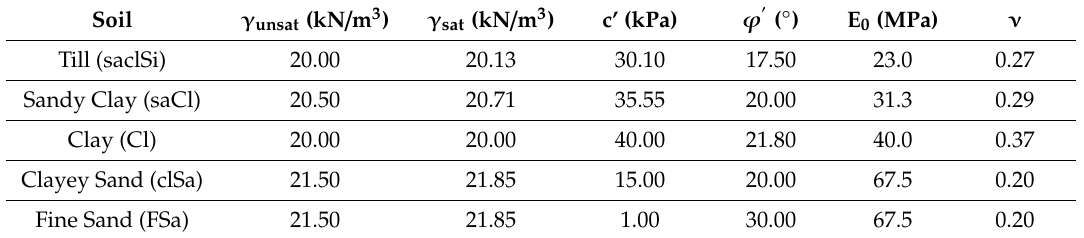
Table 5. Geotechnical parameters used for geotechnical analysis